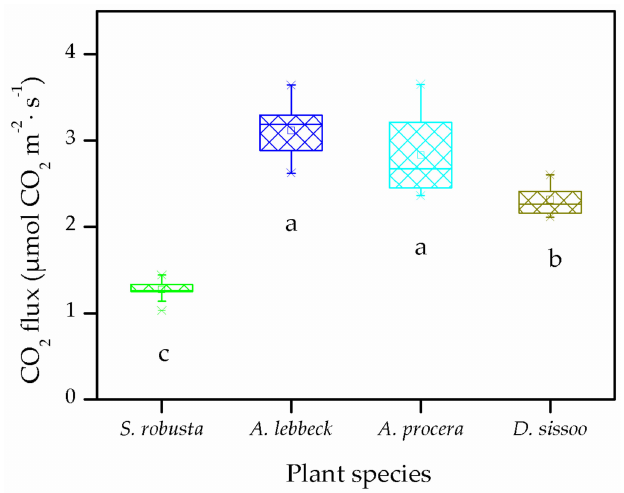
Figure 4. Variation in soil CO 2 flux ( µ mol CO 2 m − 2 · s − 1 ) under natural forest ( Shorea robusta) and a ff orested mine land ( Albizia lebbeck, Albizia procera, and Dalbergia sissoo) . (Box represents the interquartile range of the data set, and the upper and lower limits of the box show the first quartile and third quartile of the data. Middle line and dot show median and mean value, respectively. Whiskers represent the upper and lower range of the data). Di ff erent letters (a, b, c) indicate a significant di ff erence at p < 0.05, where “a” indicates a significantly higher value, “b” indicates values which are significantly lower than “a” but significantly higher than “c”, and “c” alone indicates a significantly lower value ( p < 0.001). The total ecosystem carbon pool (carbon sequestered by the plant biomass and soils) was determined in terms of CO 2 equivalent. After eight years of a ff orestation, the results of our study show less amount of carbon sequestered by the a ff orested mine land compared to the natural forest